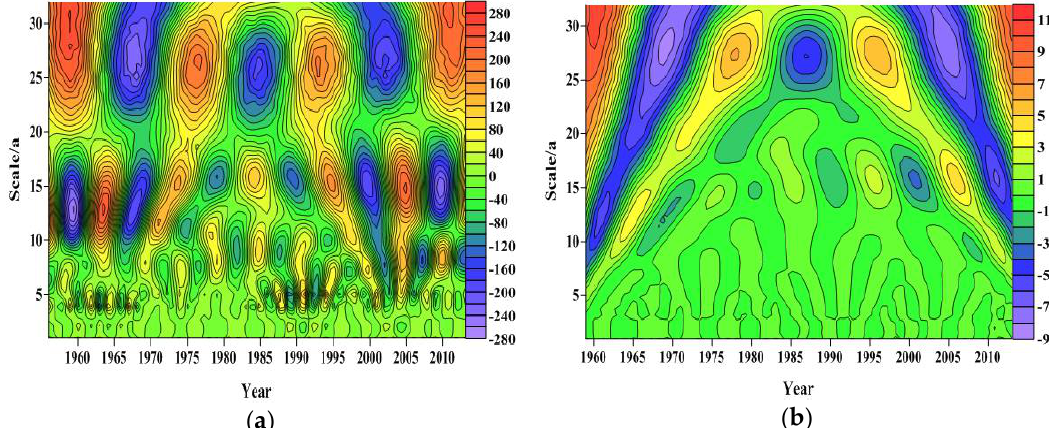
Figure 4. Wavelet coefficient contour map. ( a ) For atmospheric precipitation; ( b ) for spring water level.